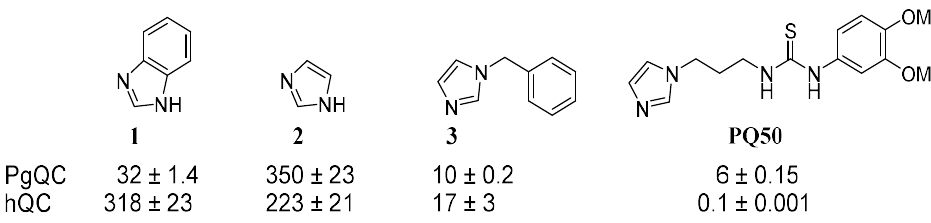
Figure 1. Comparison of inhibitory activities (K i -values in µ M) of zinc-binding fragments and PQ50 against QC from P. gingivalis and human QC.